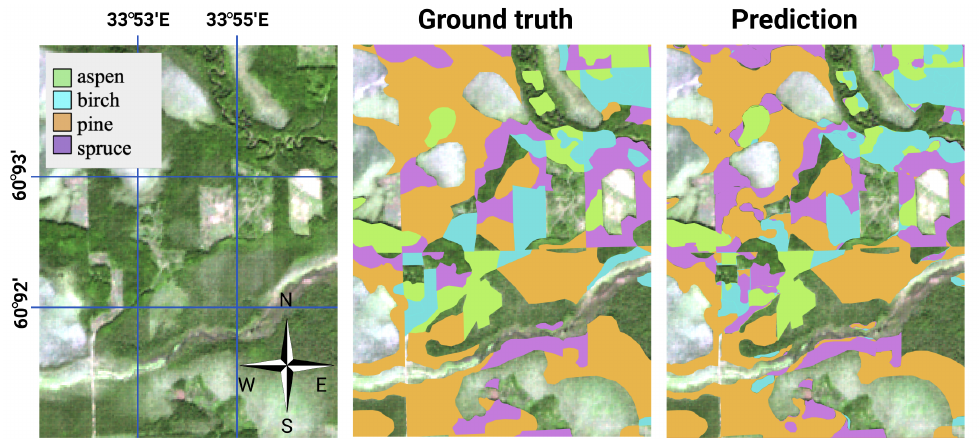
Figure 9. Sentinel-2 RGB image (tile id is L2A_T36VWN_A010343_20170615T090713). Final predic- tions using modified sampling approach and adjustment